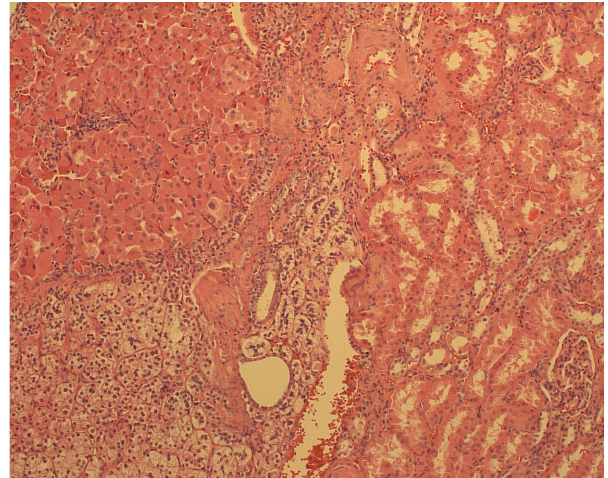
Figure 3. Histopathology section showing diffuse proliferation of oncocytes (upper left part) with a background of ectopic adrenal gland (lower left part) and renal parenchyma (right) (Haematoxyline-eosin staining, magnification 200×). The follow-up of this patient (approximately 2 years by the date of article submission) was uneventful. No additional treatment was